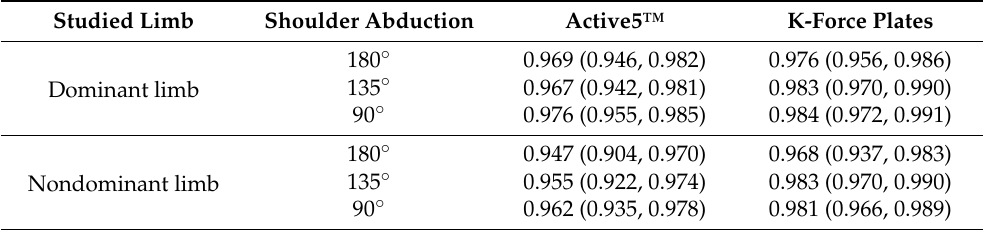
Table 3. Inter-rater reliability of the ASH test in the female group using both studied devices. Studied Limb Shoulder Abduction Active5™ K-Force Plates 180 ◦ Dominant limb